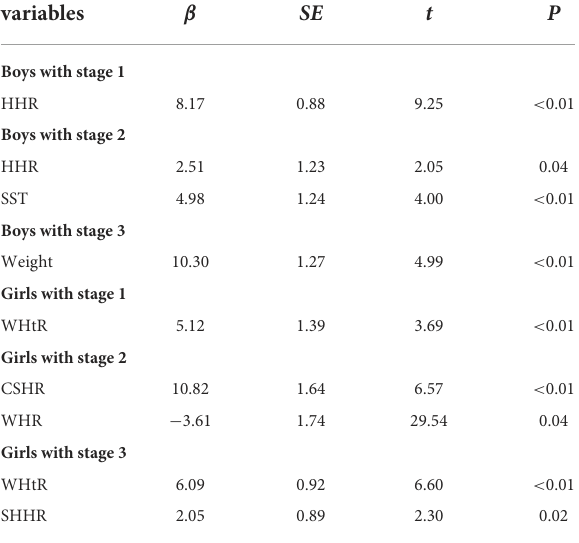
TABLE 3 The results of multiple linear regressions on associations between body anthropometric indices and body image dissatisfaction.